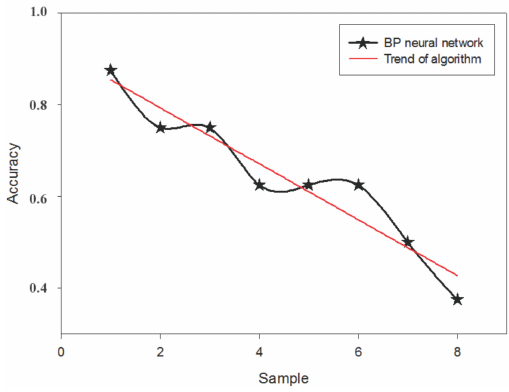
Figure 11. BP neural network algorithm for marine fuel system fault diagnosis.